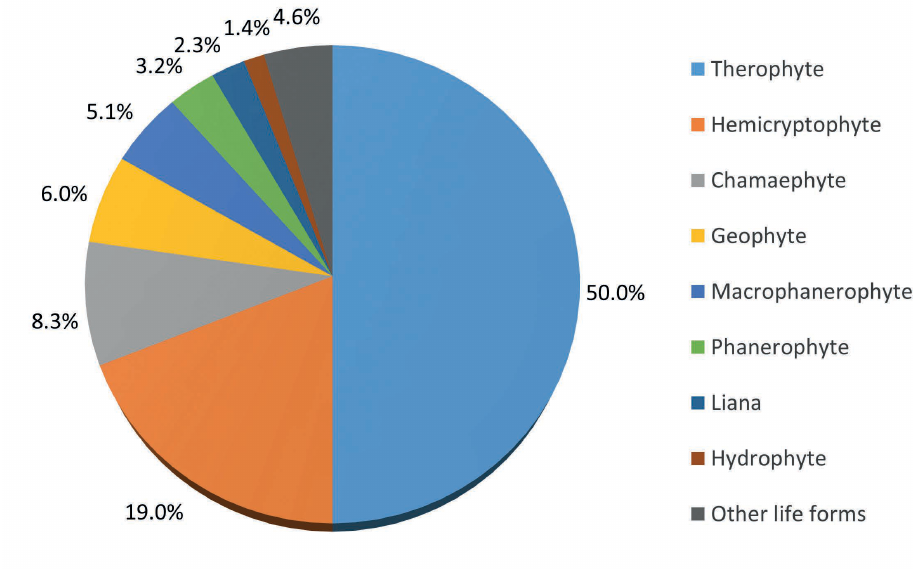
Figure 5 – Relative proportion of life forms shown by alien plant species present in Anaga Rural Park (Tenerife, Canary